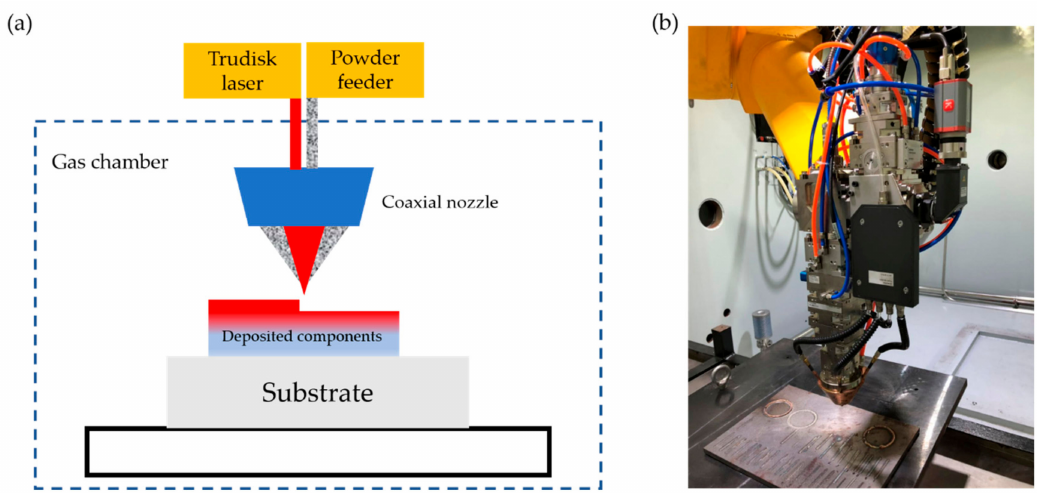
Figure 1. ( a ) The schematic and ( b ) the raw equipment of the laser melting deposition (LMD) process.